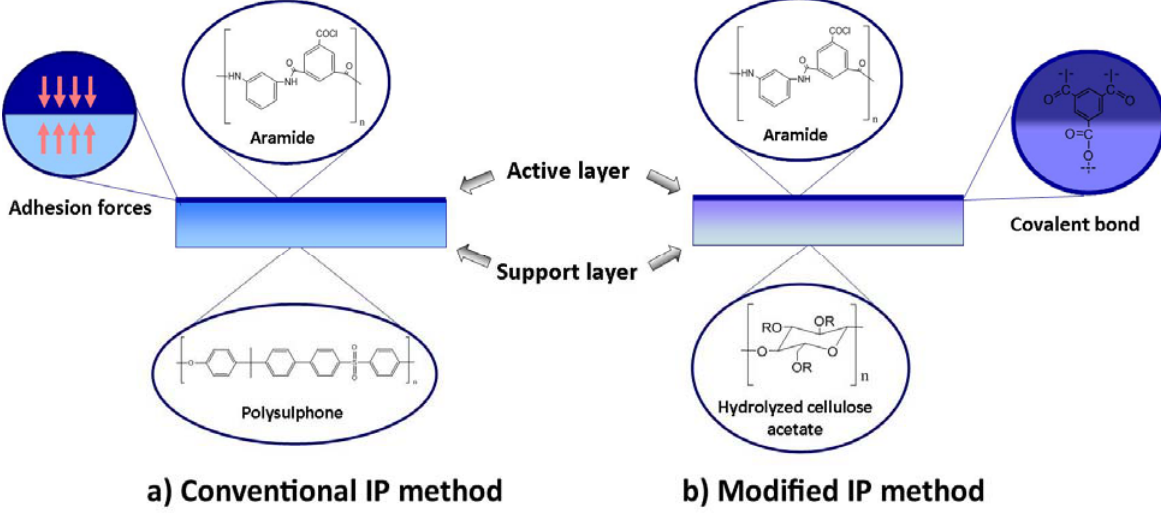
Figure 11. A comparison of a conventional TFC membrane ( a ) where the active layer stays on the support by adhesion forces; and the modified IP method ( b ) with a covalent bond between the active layer and the support